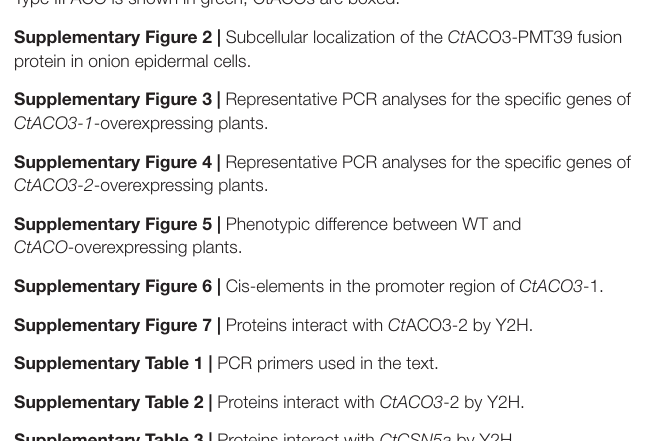
Supplementary Figure 1 | Sequence alignment for ACO protein sequences of Carthamus tinctorius (Ct), Arabidopsis thaliana (At), Solanum lycopersicum (Sl),